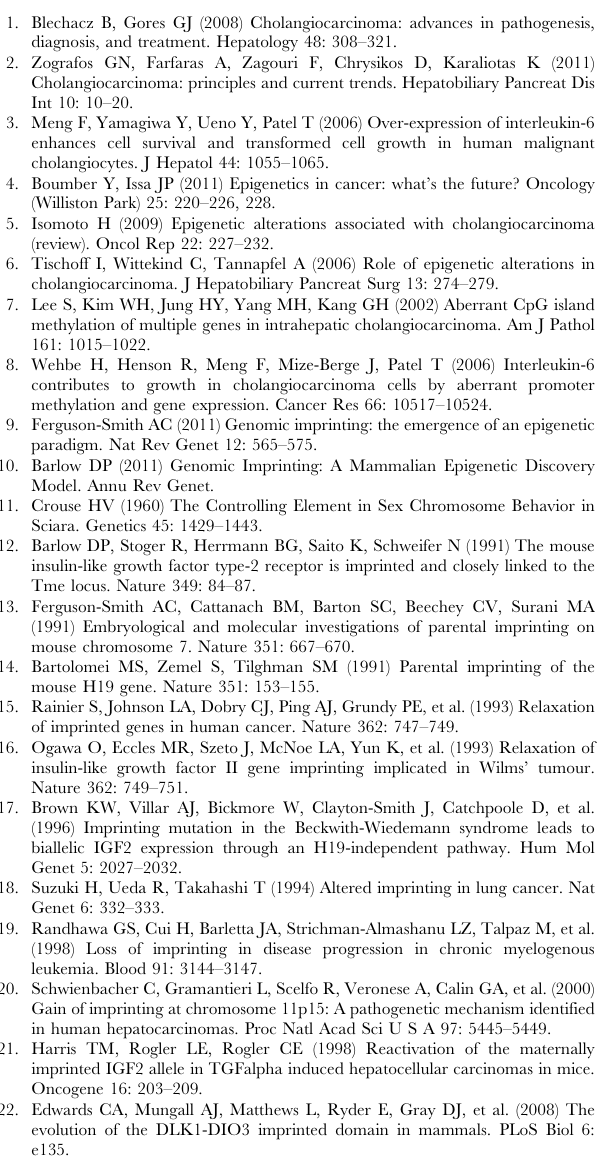
RNU6B. Data represents the mean value of three independent experiments. Mean 6 SD. ***P , 0.001. Figure S2 HCT116(-) cells display decreased growth upon miR-370 reinforced expression. X-axis –HCT116(-) cells counted at day 2, 4, 6 and 8 after transfection of miR-370 mimic. Y-axis – counts 6 10 4 of HCT116(-) cells transfected with miR-370M (squares) or the control non-specific mimic (NSM - circles). Data represents the mean value of five independent experiments. Mean 6 SD. **P , 0.01. Figure S3 Wnt10b is downregulated at mRNA level by miR-370. Y-axis – level of wnt10b in HuCCT1-EV cells (control cells) and in HuCCT1-370V cells (cells overexpressing miR-370). The level of wnt10b in HuCCT1-370V is approximately 60% of the level in control cells. Values were normalized to beta-actin. (TIF)